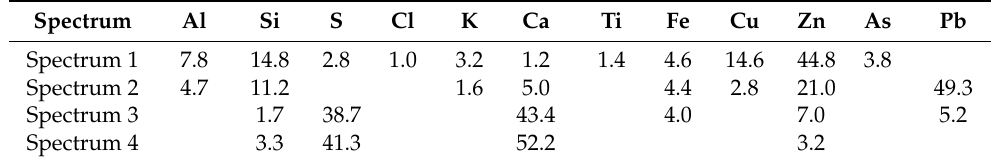
Figure 7. SEM images of samples 2 and 3. Image of sample 2 ( a ) with the indication of the different sections (A corresponds to the primer layer, B to the canvas, and C to the paint layer) and the analyzed areas corresponding to the results in Table 5. Image of the layers from the preparation layer to the paint layer ( b ) with the indication of the analyzed areas corresponding to the results in Table 6. Table 6. Elements detected through EDS analysis of the areas shown in Figure 7b. Results are reported in weight percentage (w%) removing the counts of oxygen and